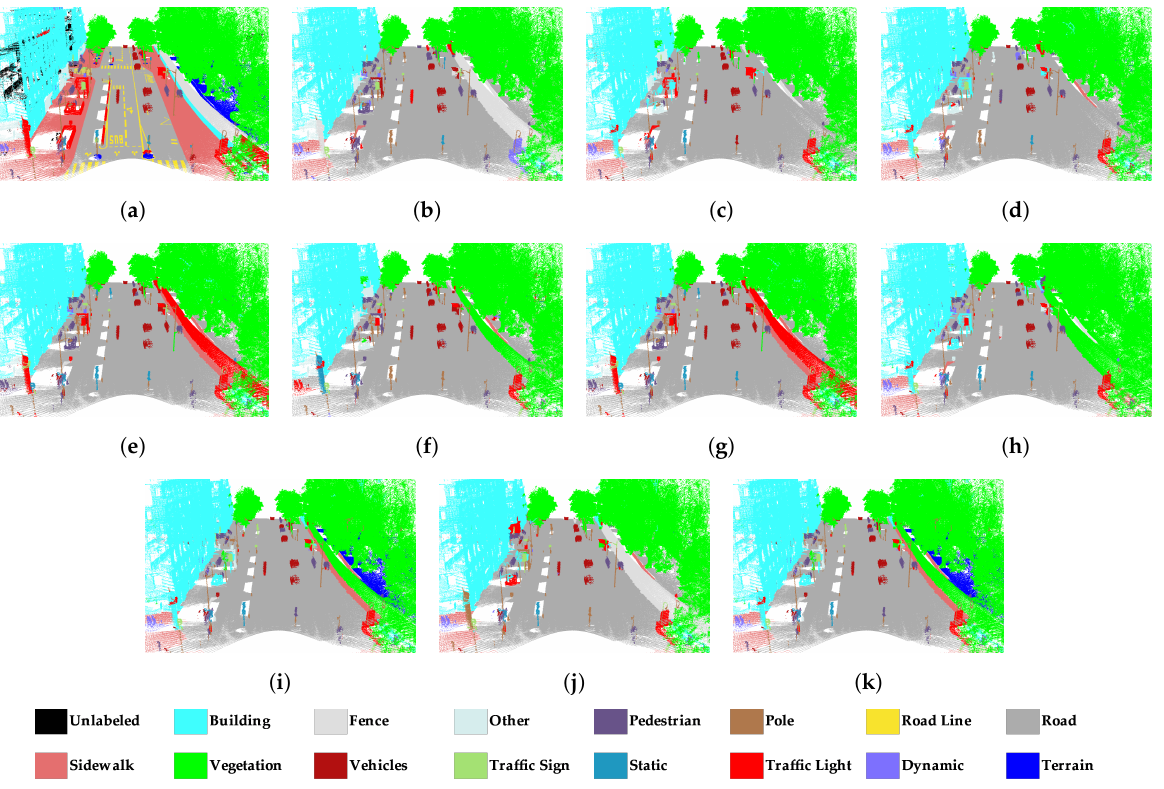
Figure 10. Qualitative results of the methods for Paris dataset with SPG. ( a ) Ground Truth; ( b ) P 1 ; ( c ) P 2 ; ( d ) P 3 ; ( e ) P 4 ; ( f ) P 5 ; ( g ) P 6 ; ( h ) P 7 ; ( i ) P 8 ; ( j ) P 9 ; ( k ) P 10